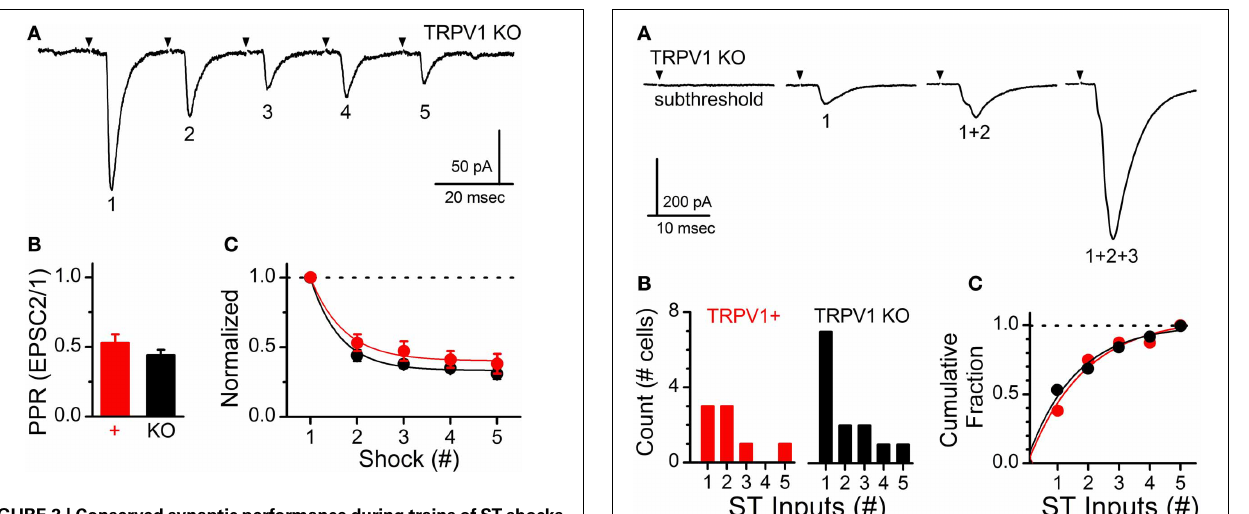
FIGURE 2 | Conserved synaptic performance during trains of ST shocks betweencontrolandTRPV1KOafferents.(A) Representativecurrenttrace showingdecreasingST-evokedEPSCsduringatrainofSTshocks(5shocksat 50Hz). Traces are of individual sweeps with the black arrow indicating the time of ST activation. The stimulus artifacts have been removed. This frequency dependent depression (FDD) is a result of a high initial probability ofvesiclerelease(P r )andrelativelyfaststimulationsreleasingvesiclesfaster thantheycanbemobilizedtothemembrane. (B) Thepaired-pulseratio(PPR) comparison between evoked EPSC2 to EPSC1 (20ms interval) showed no significant difference between groups ( P = 0 . 08, unpaired t -test); consistent with similar initial P r . (C) The train a stimulations produced nearly identical frequency dependent depression (FDD) profiles that were not different between groups ( P = 0 . 93, ANOVA). Dashed line provides reference to initial EPSC1 amplitude.